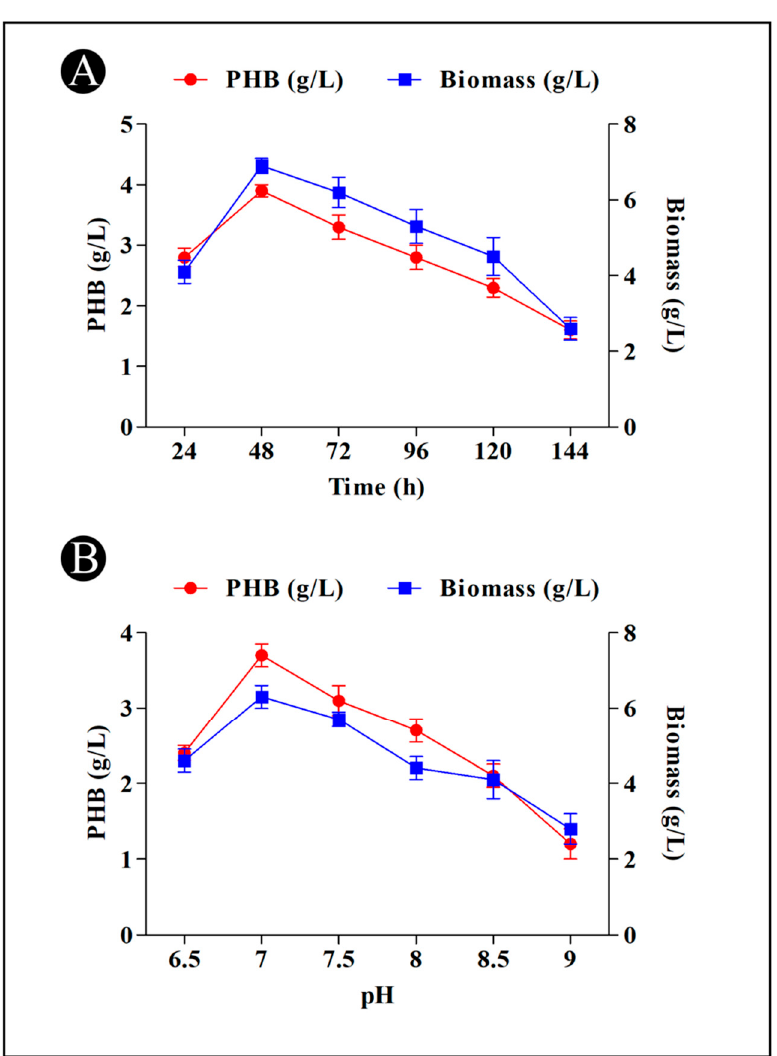
Figure 3. ( A ) Effect of incubation time on the PHB production by B. flexus strain HSA3, ( B ) Effect of Figure 3. ( A ) E ff ect of incubation time on the PHB production by B. fl exus strain HSA3, ( B ) E ff ect of pH on the PHB production by B. flexus strain pH on the PHB production by B. fl exus strain HSA3.